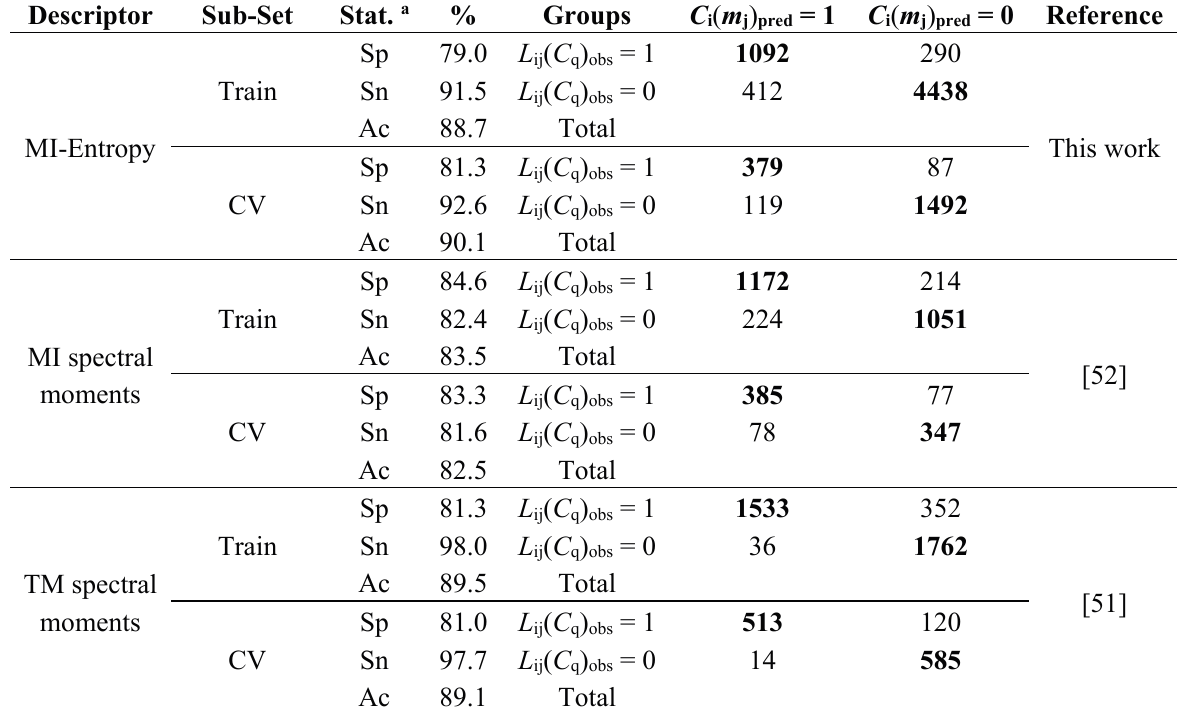
Table 1. Results of Assessing Links with Moving Averages (ALMA) models for entropy measures vs . different spectral moments.